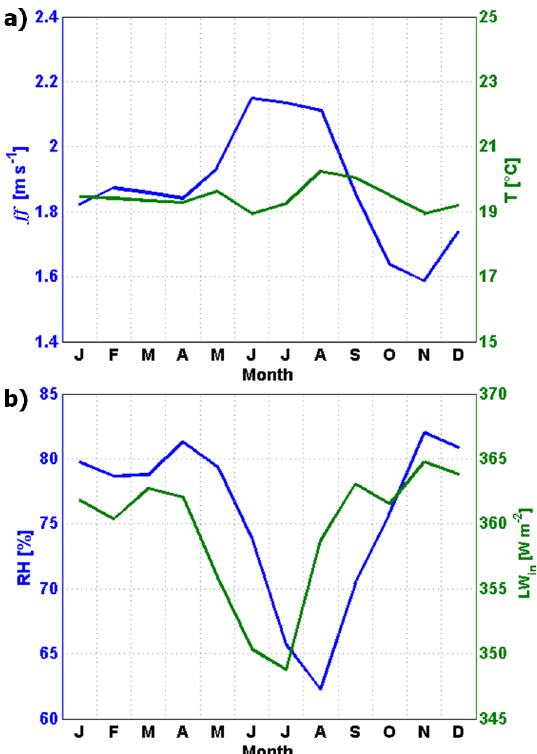
Fig. 14. Monthly averages for 2003–2011 of (a) wind velocity ff (ms − 1 ) and air temperature T ( ◦ C); (b) relative humidity RH (%) recorded at Automatic Weather Station (AWS) 1 and incoming long-wave radiation LW in (Wm − 2 ) from ERA-Interim. Note the different y axes